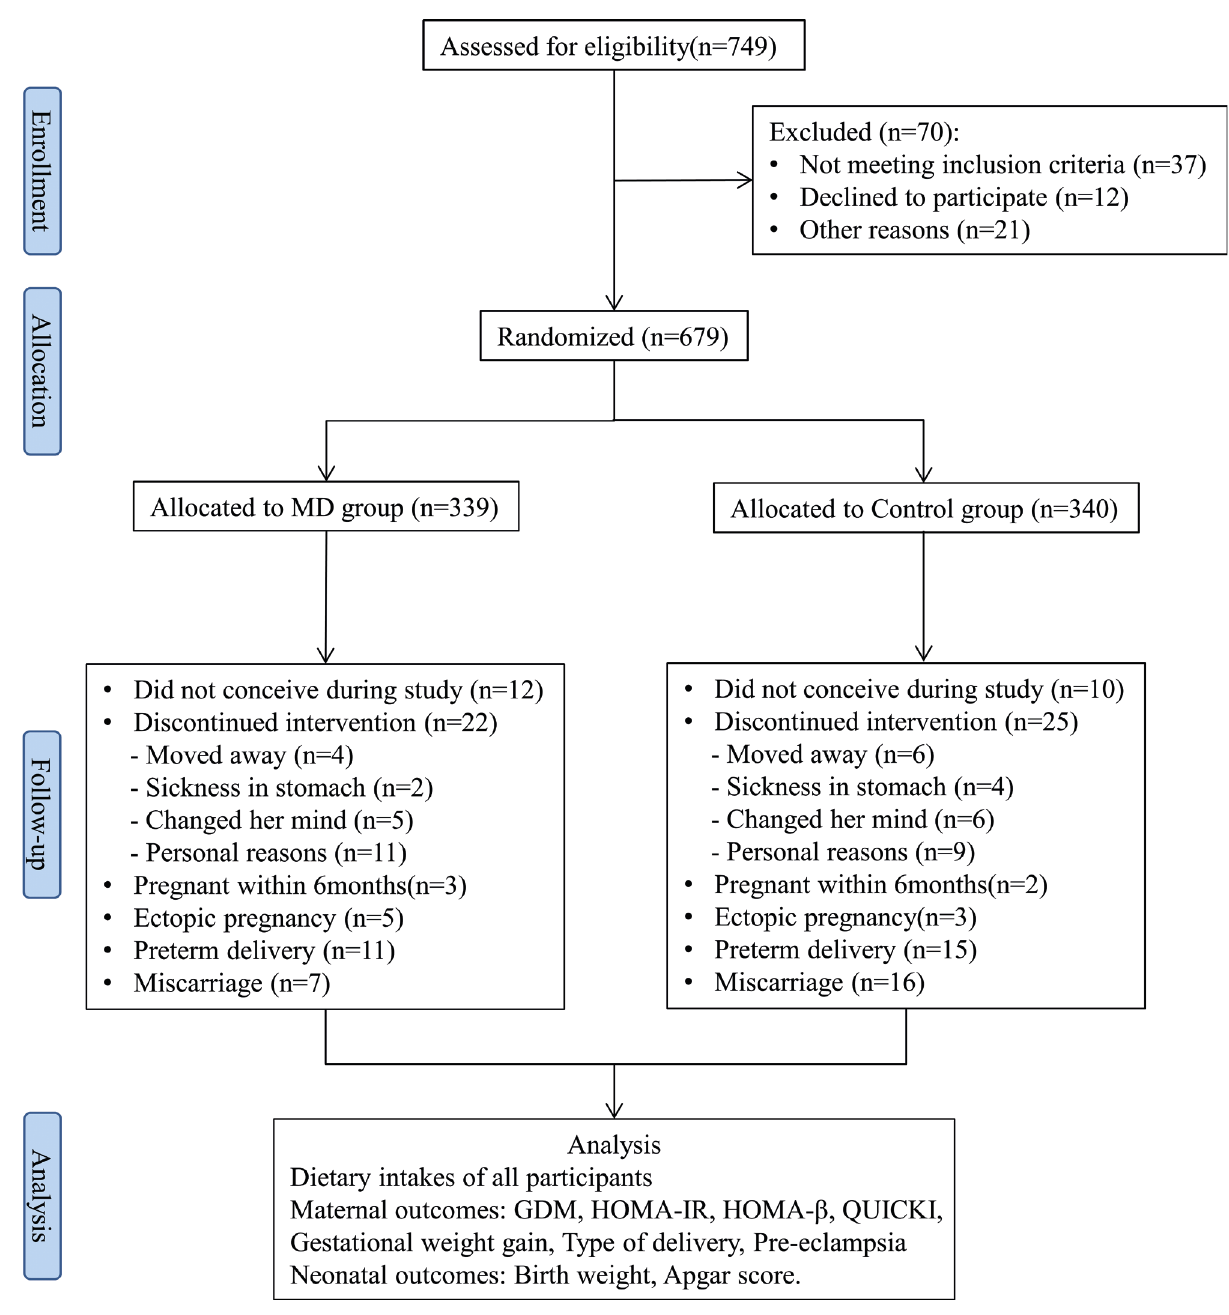
Fig. 1. Flow diagram of the study design: participant selection, allocation, and follow-up. MD group, Mediterranean Diet